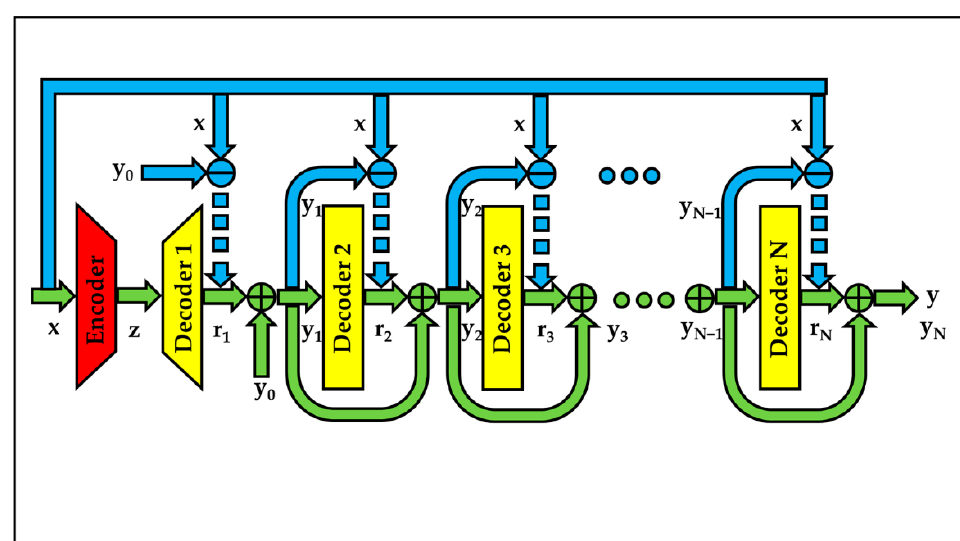
Figure 4. The architecture of residual cascade decoders-based auto-encoders.